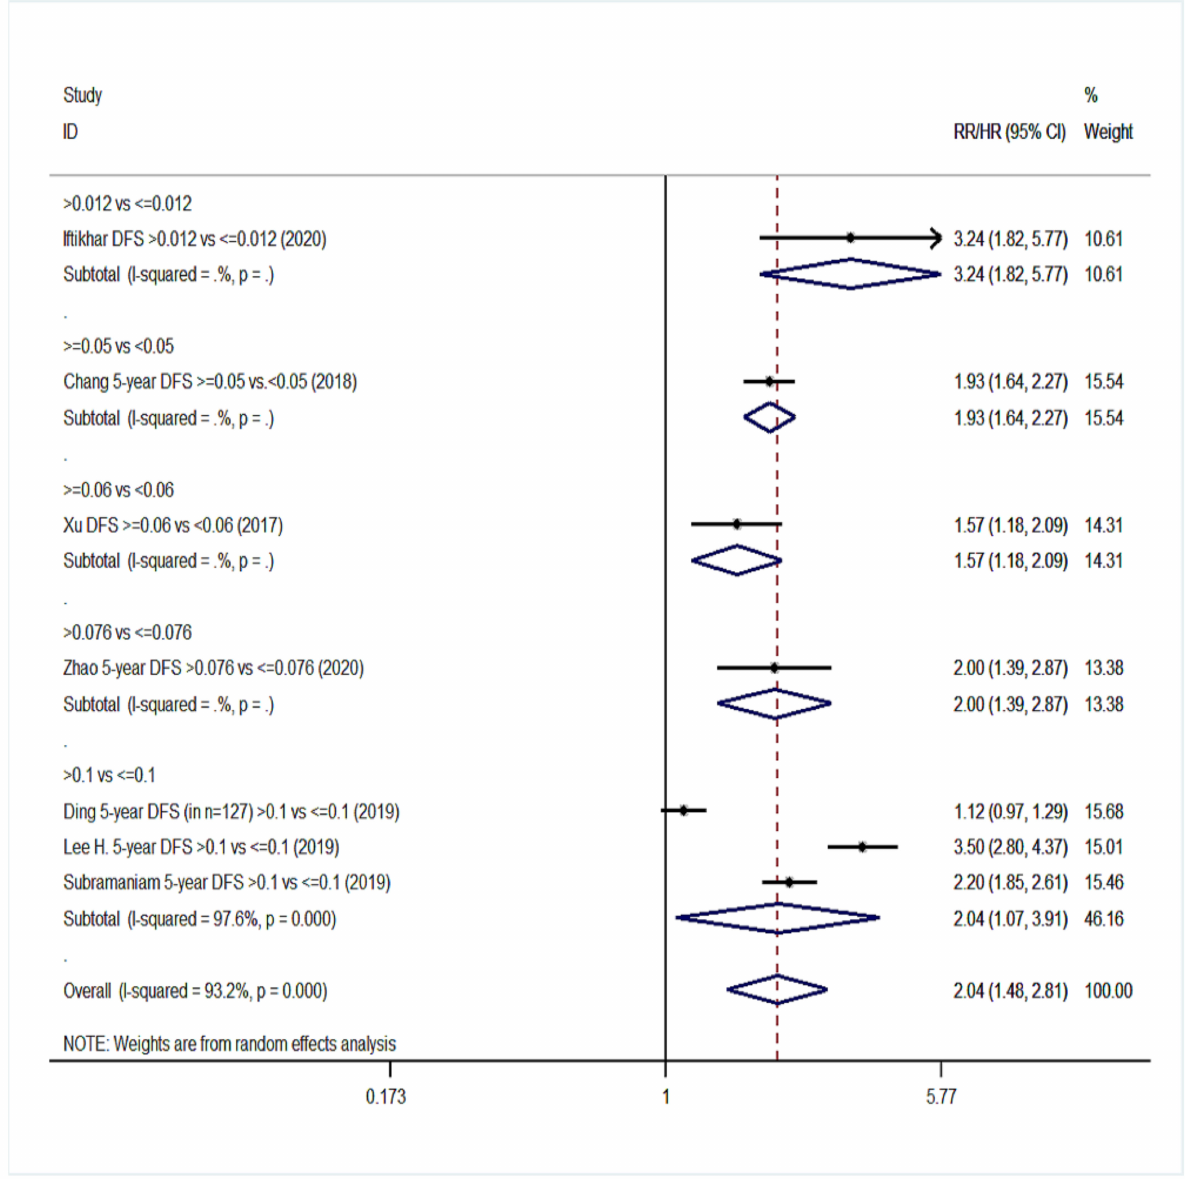
Figure 9. Forest plot describing the association between lymph node ratio (LNR) and disease-free survival (DFS) in group NO. Apart from the overall analysis, the subanalyses by LNR cut-off values are